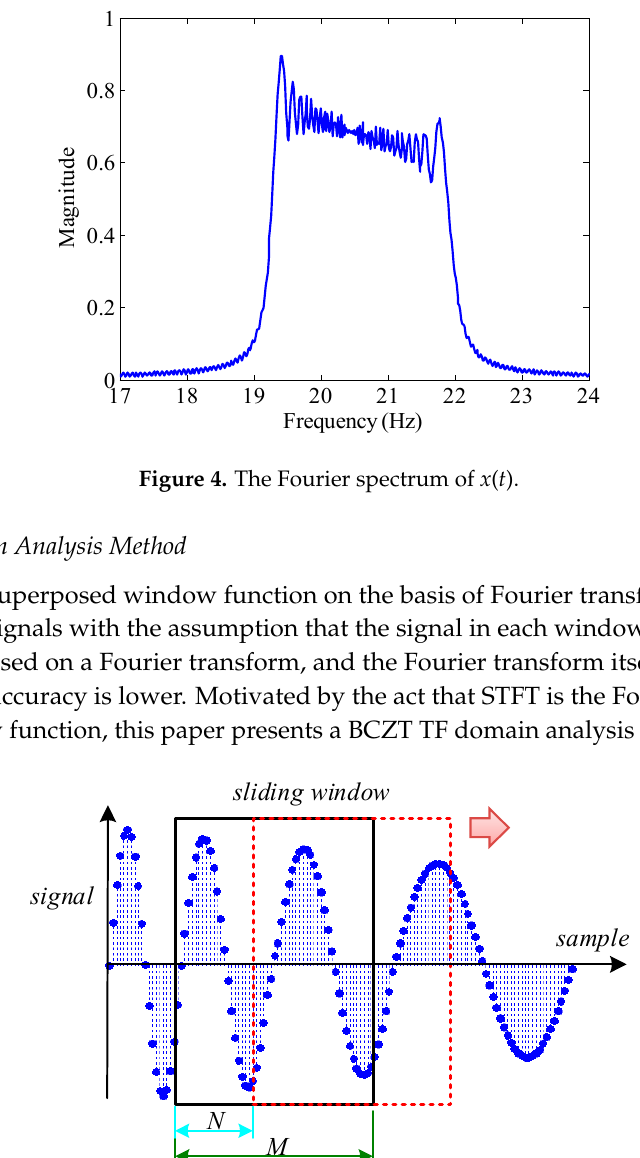
Figure 3. The time domain waveform of x ( t ) and its local enlarged drawing.